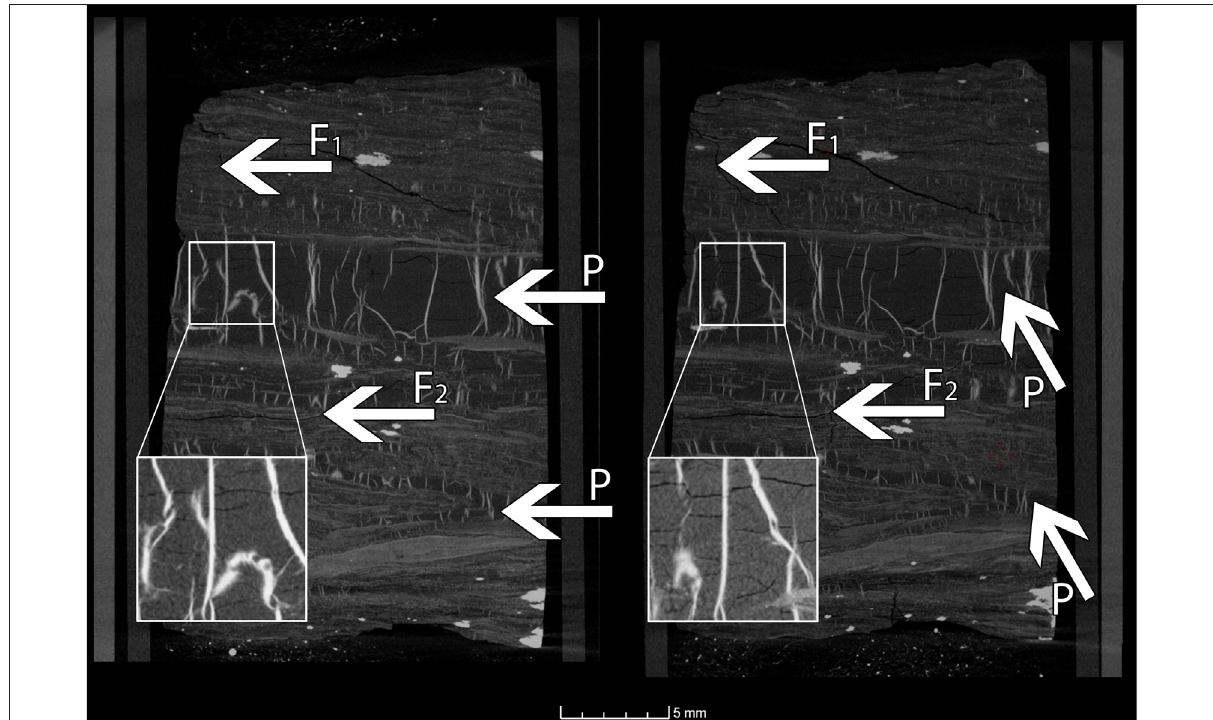
F indicates cleats or cracks that existed in the pre-loaded particles that enlarged during compression; P indicates either maceral–maceral boundaries or maceral–mineral boundaries that may have had an influence on crack initiation. Figure 9: Comparison of a particle before (left) and after (right) it was heated to 700 ºC at a rate of 51